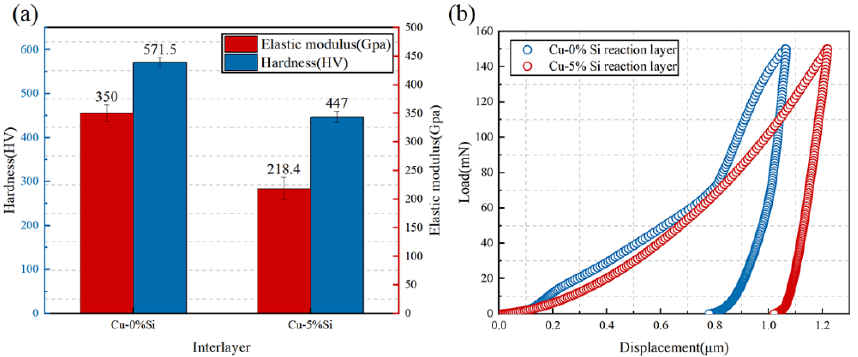
Figure 10. Microhardness of joints without Si and with 5%Si: ( a ) Cu − 0%Si and( b )Cu − 5%Si.